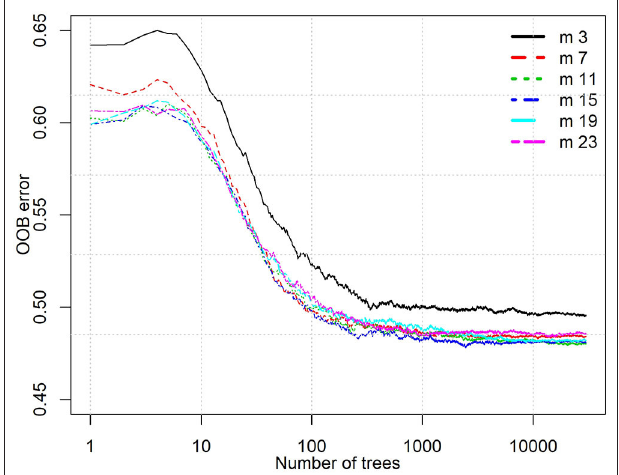
FIGURE 2 | The OOB error with respect to number of trees for different predivtive variables for split node (m).